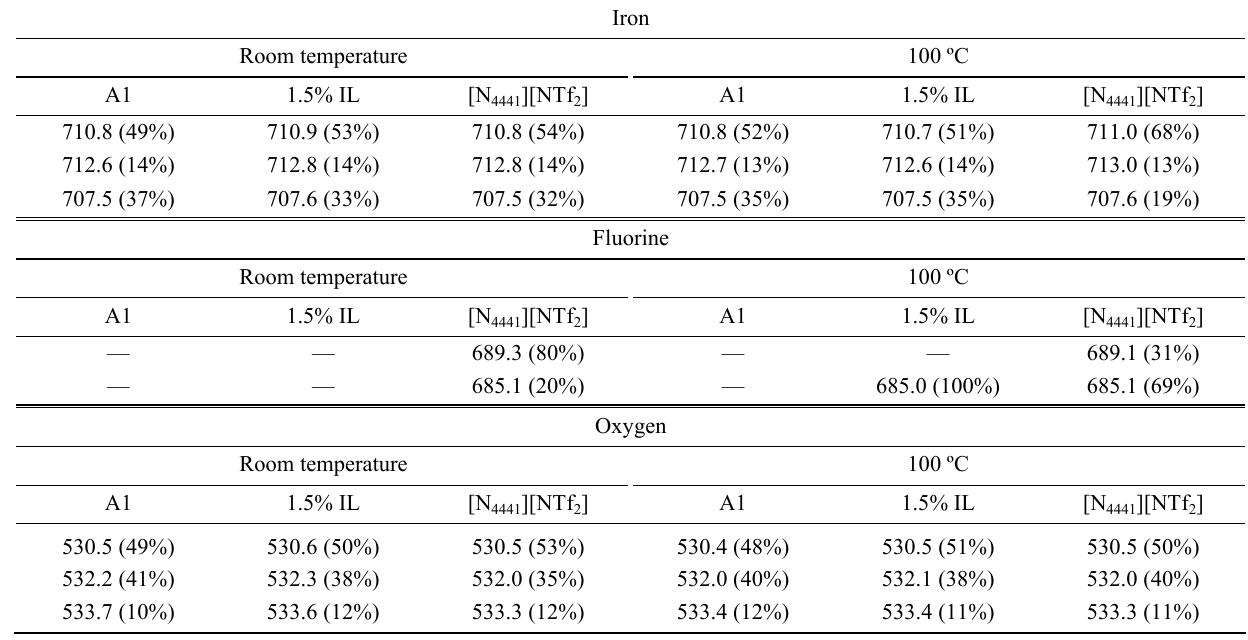
Table 1 Positions in eV of the photoelectron peaks of iron and fluorine. In brackets the relative amount of this species with respect to the total amount of the